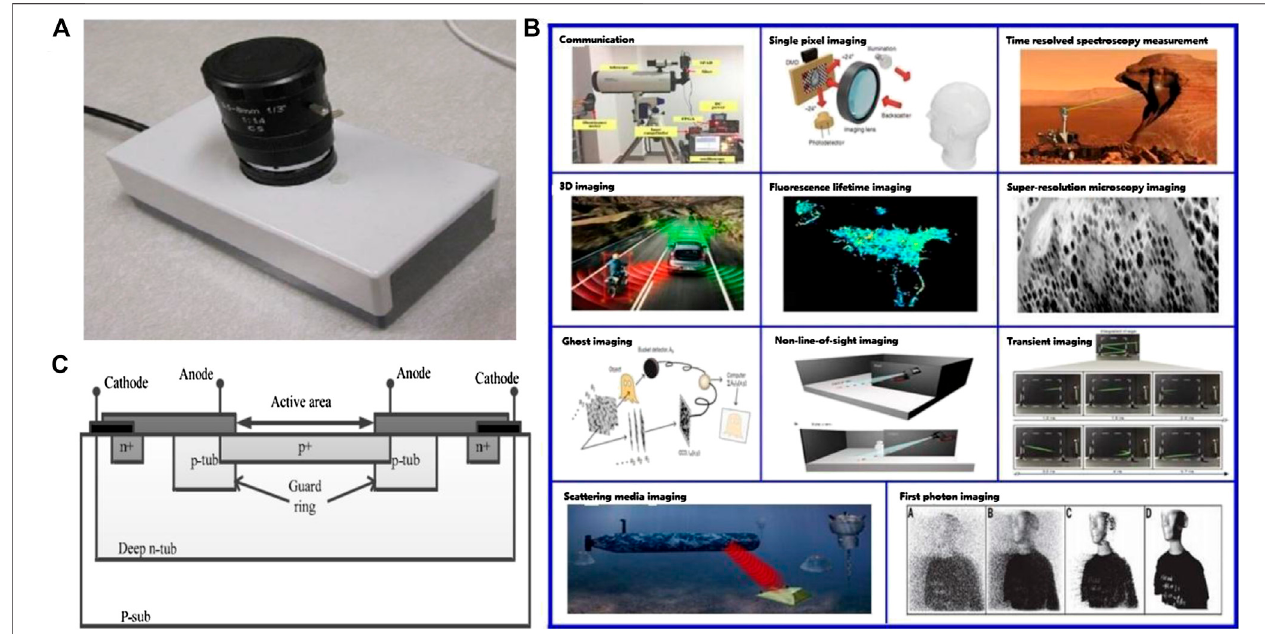
FIGURE 1 | (A) Packaged SPAD optical imager. Source : Reproduced from Ref. 7. (B) applications of SPAD. (C) the Silicon-based SPAD structure diagram compatible with CMOS process. Source : Reproduced from Ref. 15.